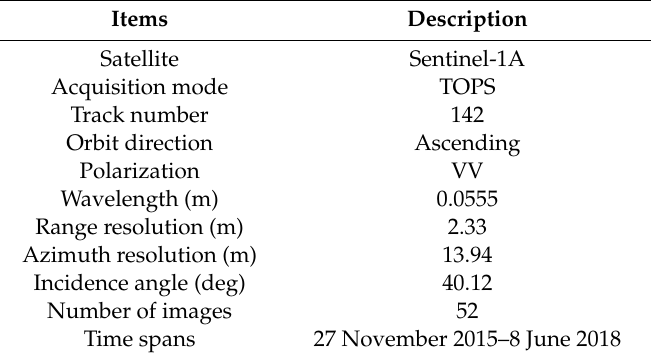
Table 1. Details of the processed SAR